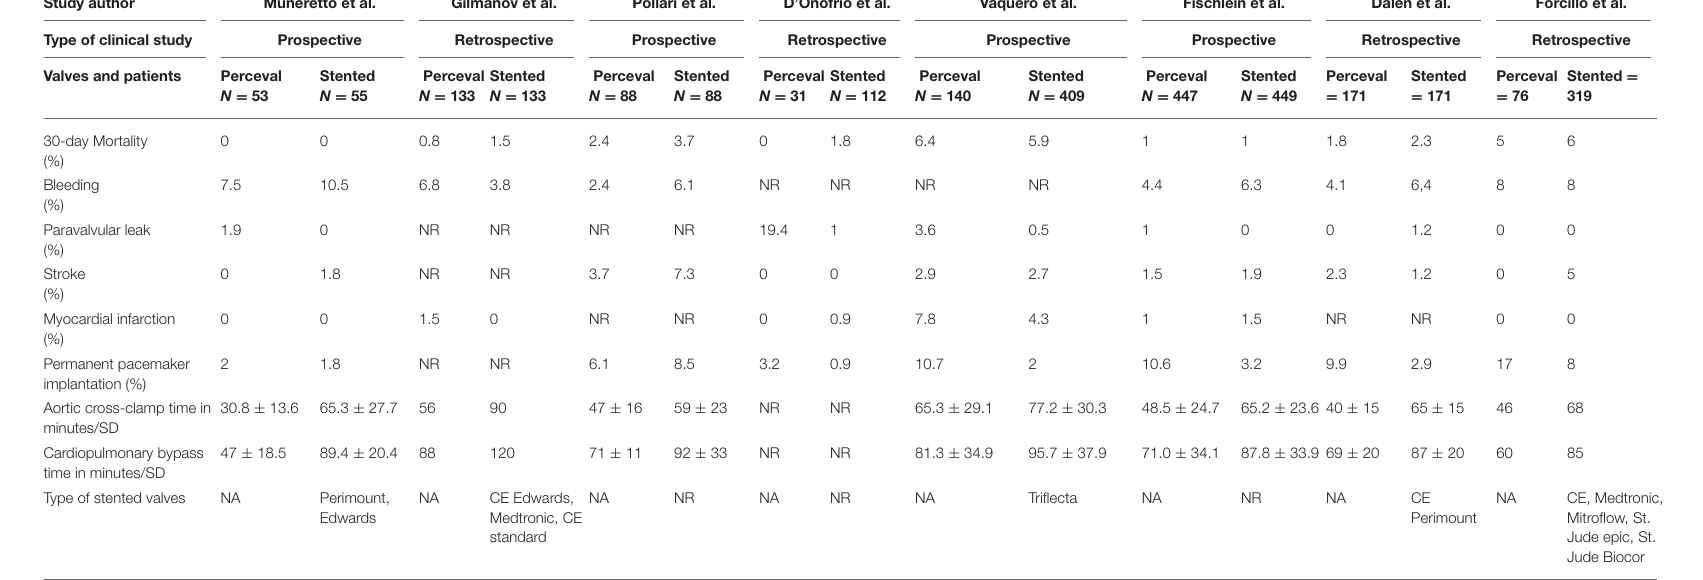
D’Onofrio et al. Vaquero et al. Fischlein et al. Dalen et al. Forcillo et